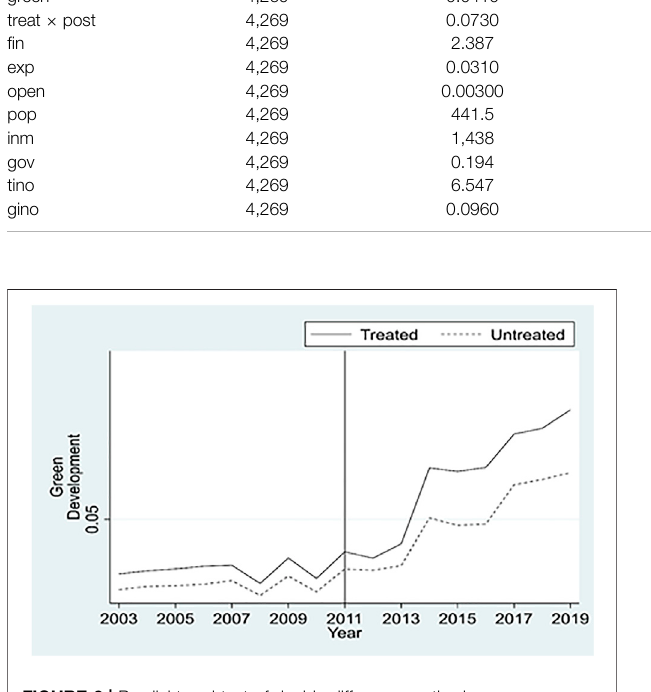
FIGURE 2 | Parallel trend test of double difference